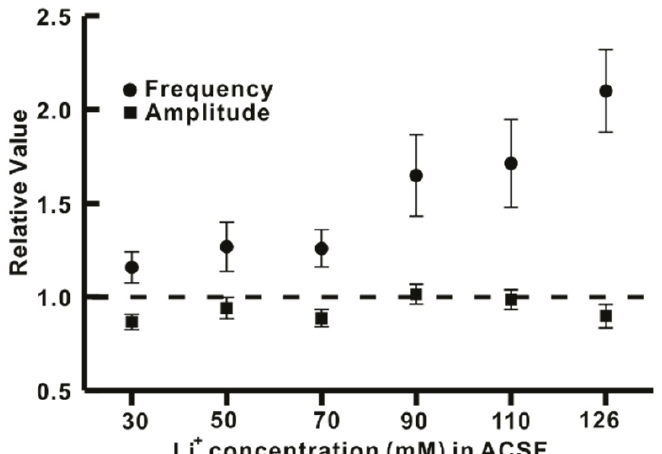
Figure 4. Concentration-dependent effect of Li + on GABAergic mIPSCs. The graph shows a concentration-dependent increase in GABAergic mIPSCs frequency by Li + without affecting the amplitude.